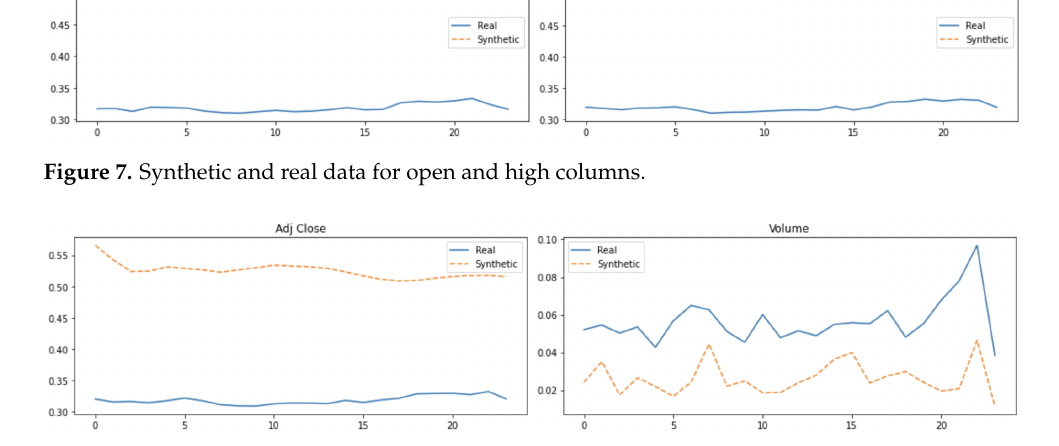
Figure 8. Synthetic data on the real data for adj_close and volume